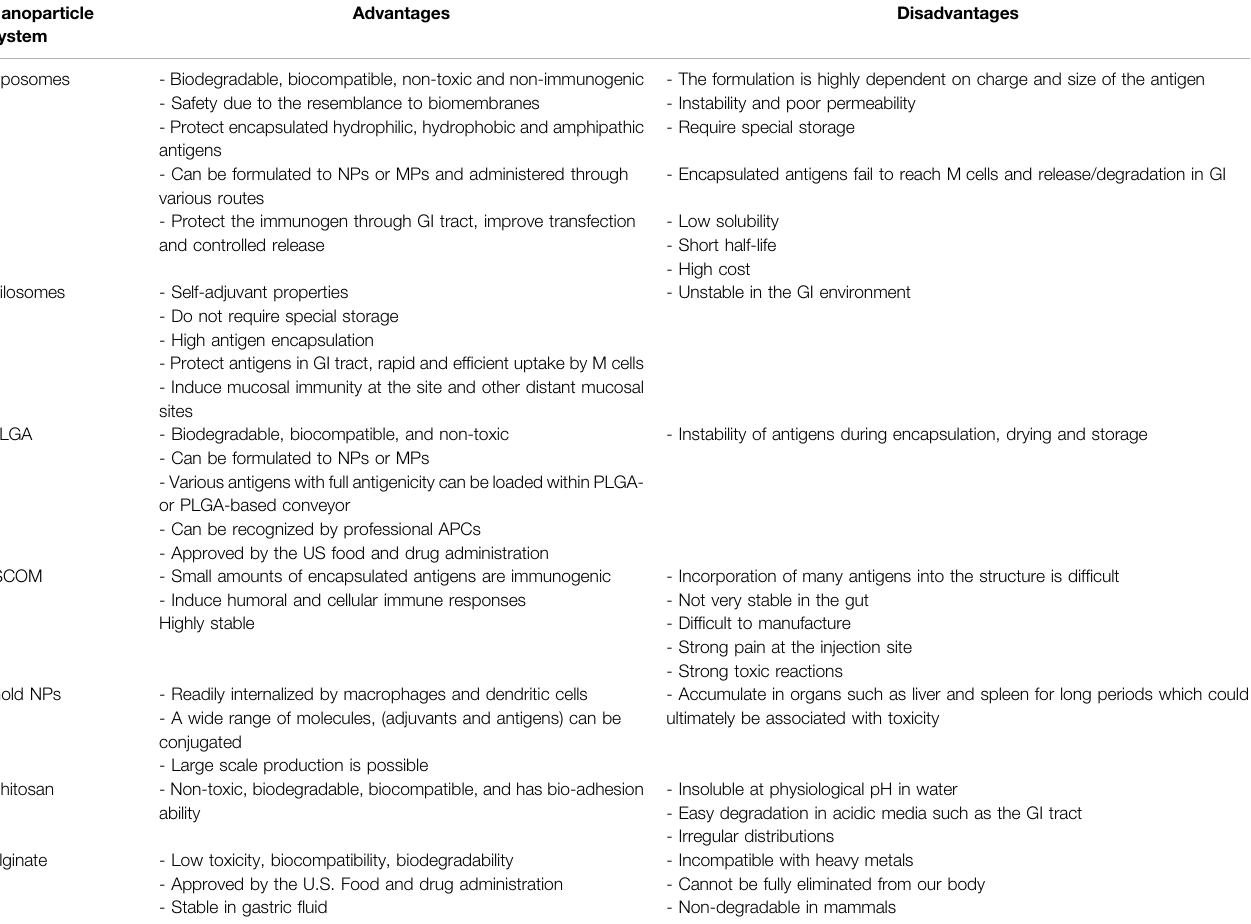
TABLE 1 | Advantages and disadvantages of the different types of nanocarriers. Nanoparticle